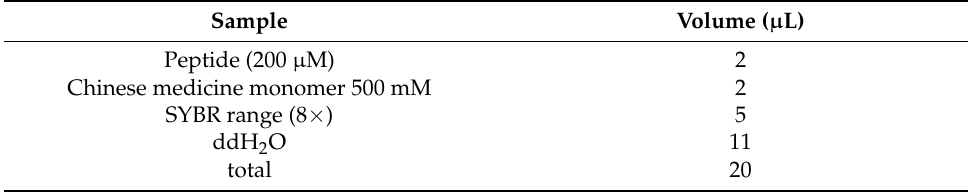
Table 3. The TSA test reaction